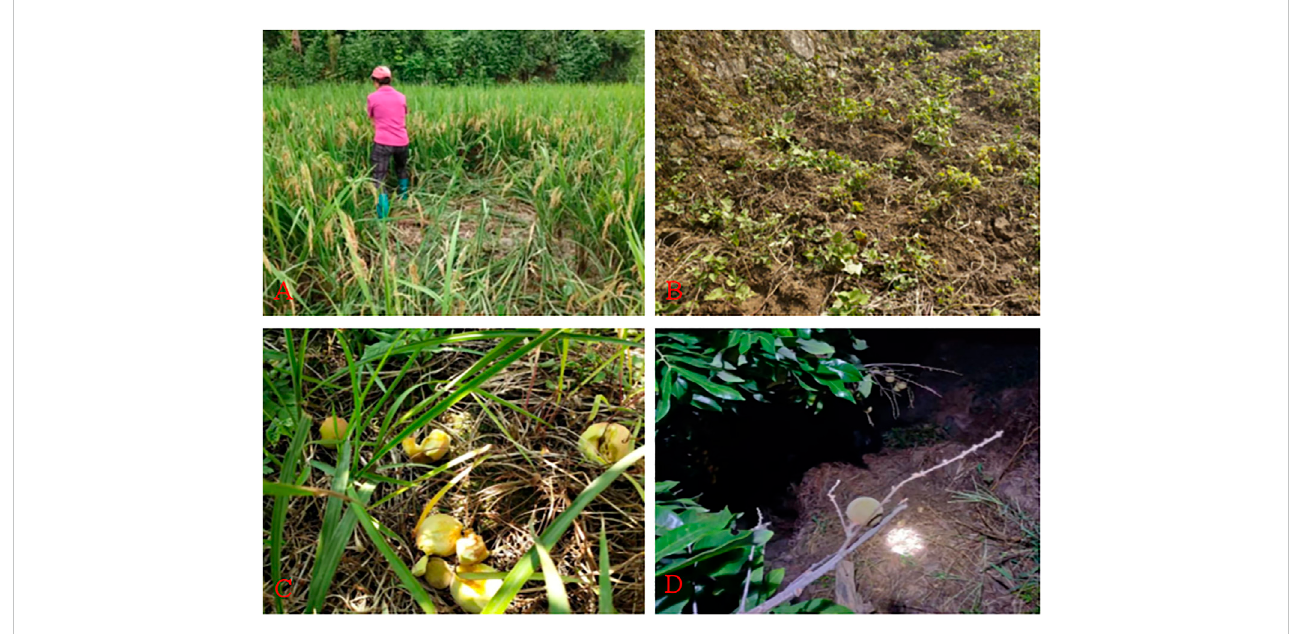
FIGURE 2 Crops damaged by wild boars: (A) Paddy (B) Sweet potato (C) Peach orchard (D) Litchi orchard.